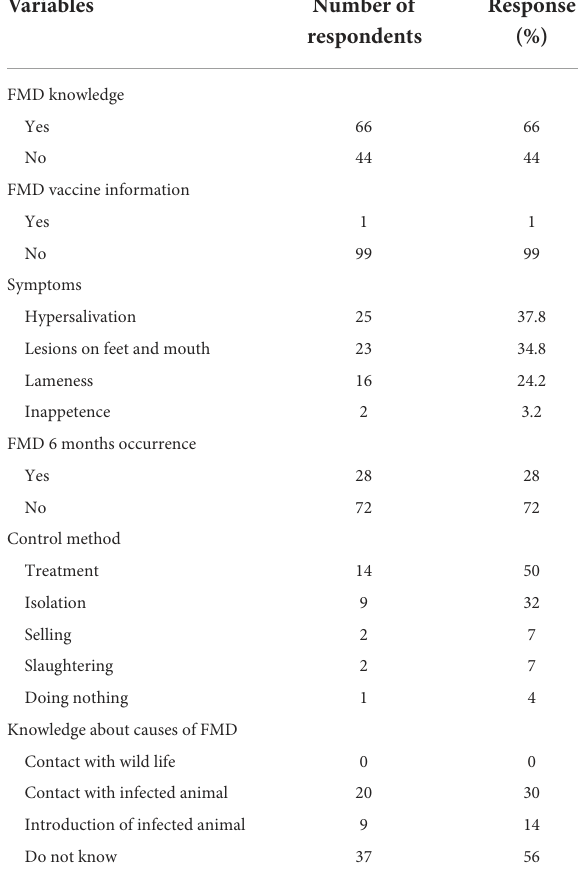
TABLE 1 Cattle owners’ response to knowledge, prevention, and control practices of FMD.